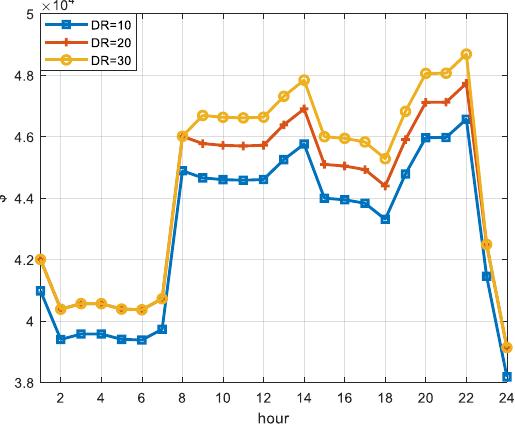
ff erent DR marginal